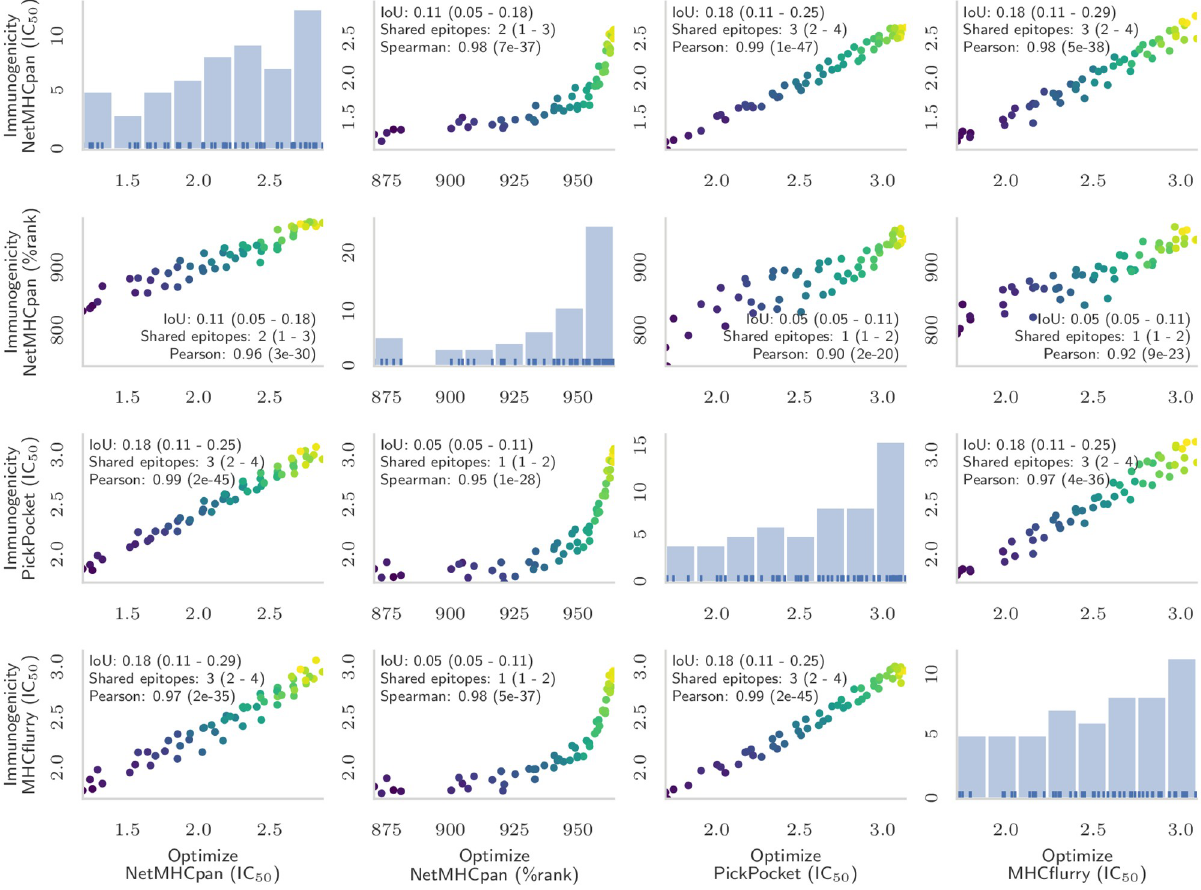
Fig 9. Effect of different immunogenicity predictors on optimized vaccines. Each scatter plot shows the immunogenicity predicted by a certain method ( y axis), when the ten-epitopes string-of-beads vaccine was designed optimizing the immunogenicity predicted by a different method ( x axis). The diagonal shows the immunogenicity distribution of the optimized vaccines. The color of each point indicates the cleavage score of the vaccine (brighter is larger). Inside each scatter plot, we report the intersection-over-union (IoU) of the epitopes, the number of shared epitopes between vaccines of similar cleavage score indicating median and 25th and 75th percentile in parentheses, and the correlation coefficient (Pearson or Spearman depending on the plot) with its p -value against the null hypothesis of no correlation.